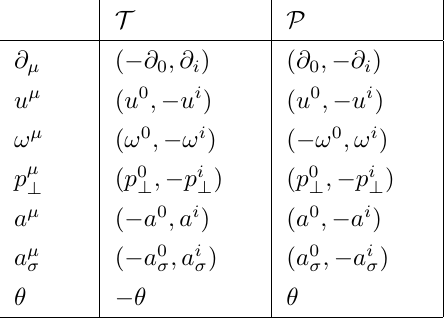
Table 1 . Transformations of various tensors under T and P